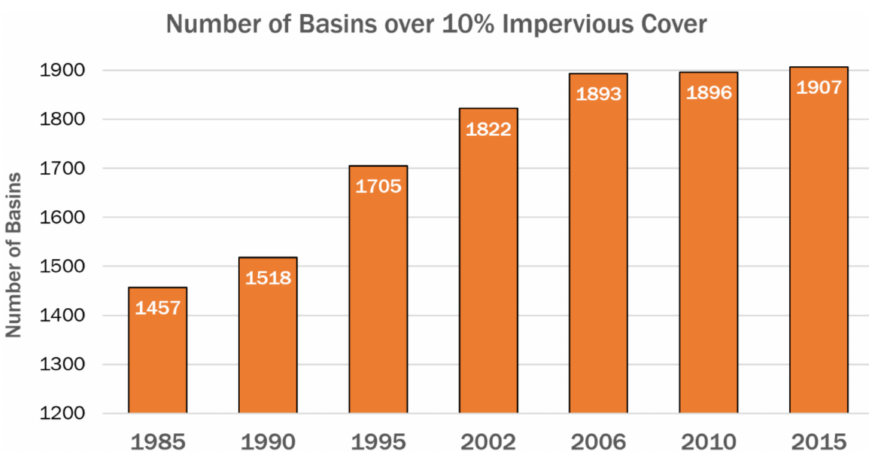
Figure 20. Number of basins for each of the seven project datasets with estimated impervious cover over 10%, a level identified in the literature as commonly related to the onset of water quality problems in the receiving